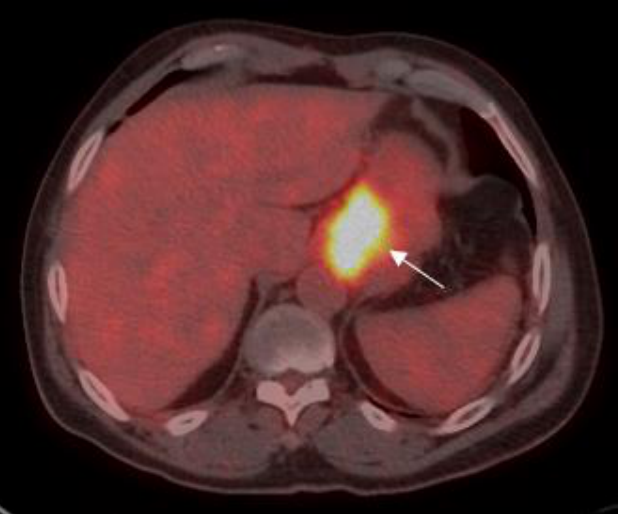
Figure 1. A 70-year old male with gastric adenocarcinoma (SRCC). Axial PET-CT images show low 18 F-fluorine-18 fluoro-2-deoxy-D-glucose (FDG) uptake (standardized uptake value (SUV) max : 16.2) in primary tumor in the body of the stomach (white arrow).